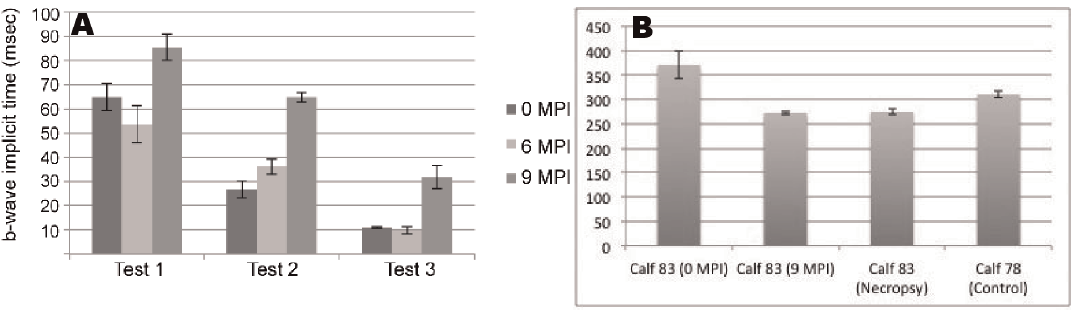
Figure 1. Results of antemortem ophthalmologic testing. ( A )Comparison of mean ERG b-wave implicit time at 0, 6, and 9 months post- inoculation (MPI). Implicit time was prolonged at 9 MPI compared to baseline (0 MPI) and 6 MPI values for all test conditions. Test 1, dark adapted 0.024 cd ? s/m 2 ; test 2, dark adapted 2.45 cd ? s/m 2 ; test 3, light adapted 2.45 cd ? s/m 2 . ( B ) Optical Coherence Tomography (OCT) was used to measure full retinal thickness, (including all retinal layers) of Calf 83 prior to inoculation (0 MPI), nine-months post inoculation (9 MPI) and one day prior to necropsy (approximately 9.8 MPI). There was an appreciable decrease in retinal thickness from 0 MPI to 9 MPI. Retinal thickness was also decreased relative to an age-matched, genotype matched, non-inoculated control (Calf 78). Error bars are standard deviation based on 10 measurements.